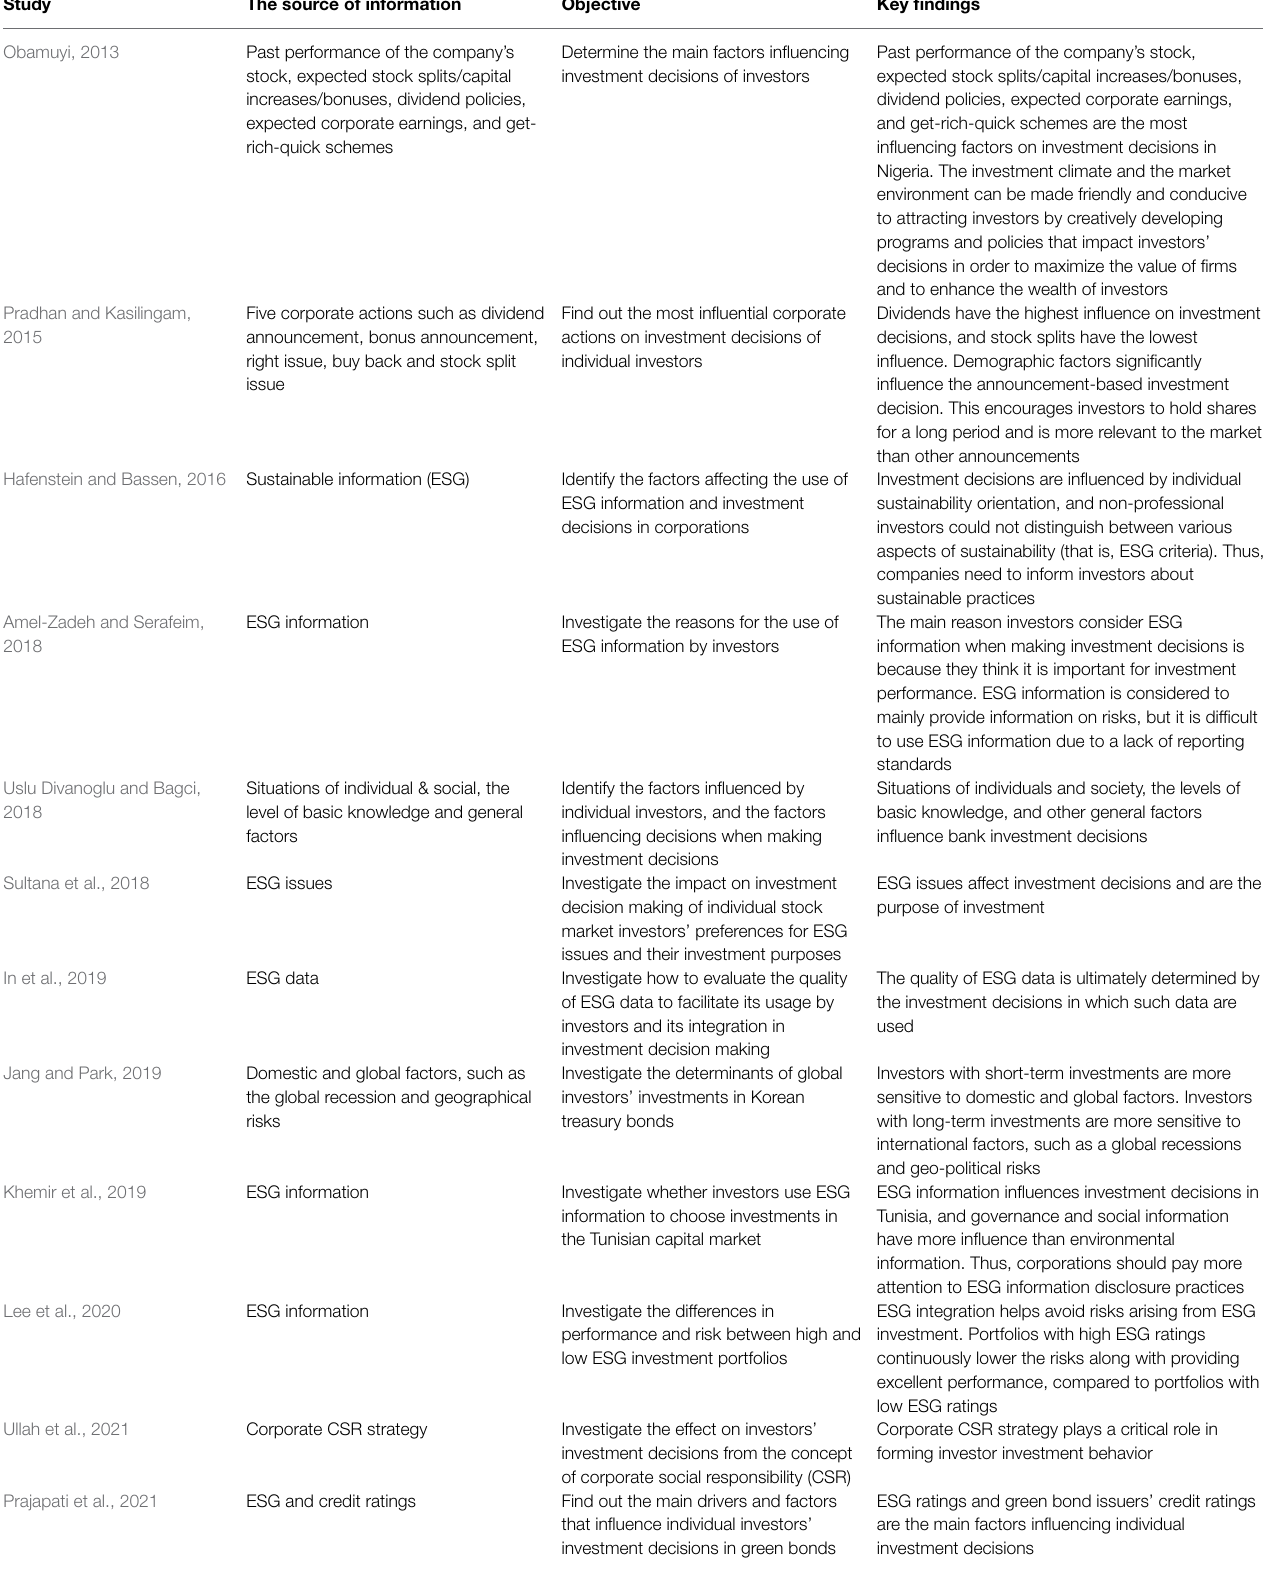
TABLE 1 | Information integrated by investors into investment